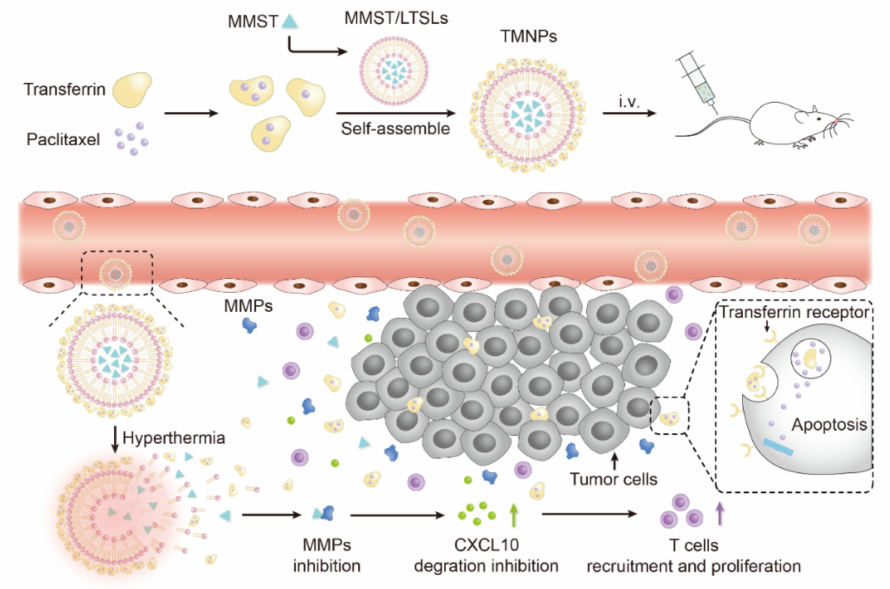
Figure 1. Schematic diagram of preparation of TMNPs and mechanism of chemoimmunotherapy. PTX@TF was prepared by precipitation-ultrasonication method and self-assembled on MMST/LTSLs surface to form hybrid nanoparticles (TMNPs). TMNPs accumulated in the tumor through EPR effect and transferrin-receptor-mediated endocytosis, and rapidly released the loaded MMST and PTX@TF by the stimulation of local hyperthermia treatment. The released MMST inhibited the activity of MMPs to reduce chemokine degradation and increased T cell proliferation and infiltration in the TME. Meanwhile, the nanocomplex PTX@TF entered tumor cells via transferrin targeting, leading to potent apoptosis of tumor cells with the facilitation of T cell